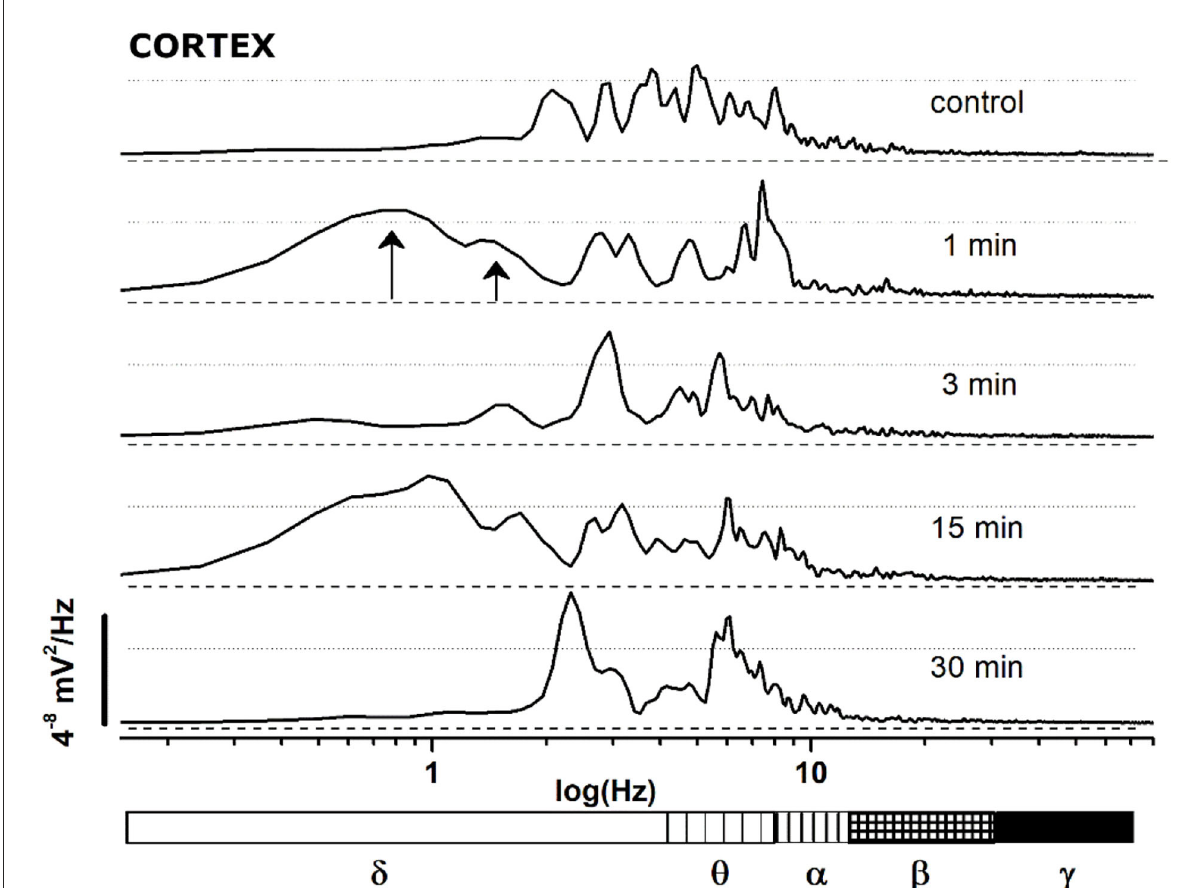
FIGURE5 FFT spectrum of a 30s window, sampled at definite time points (control and minutes 1, 3, 15, 30 after JWH-073 administration) from EEG recording of Figure 4. Textured bars under the X axis correspond to the different EEG bands indicated